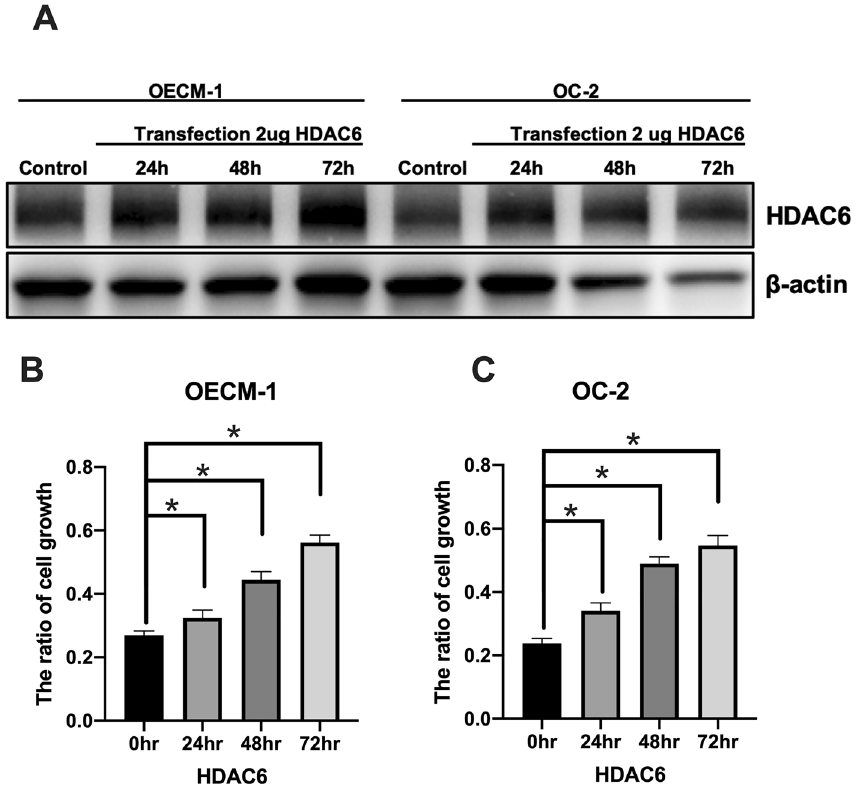
Figure 2. HDAC6 mediates the growth of OSCC cells. The HDAC6 plasmid (2 µg) was transfected into cell lines. After 24, 48 and 72 h, ( A ) the level of HDAC6 was analyzed by western blotting, and ( B and C ) cell growth was analyzed by a CCK-8